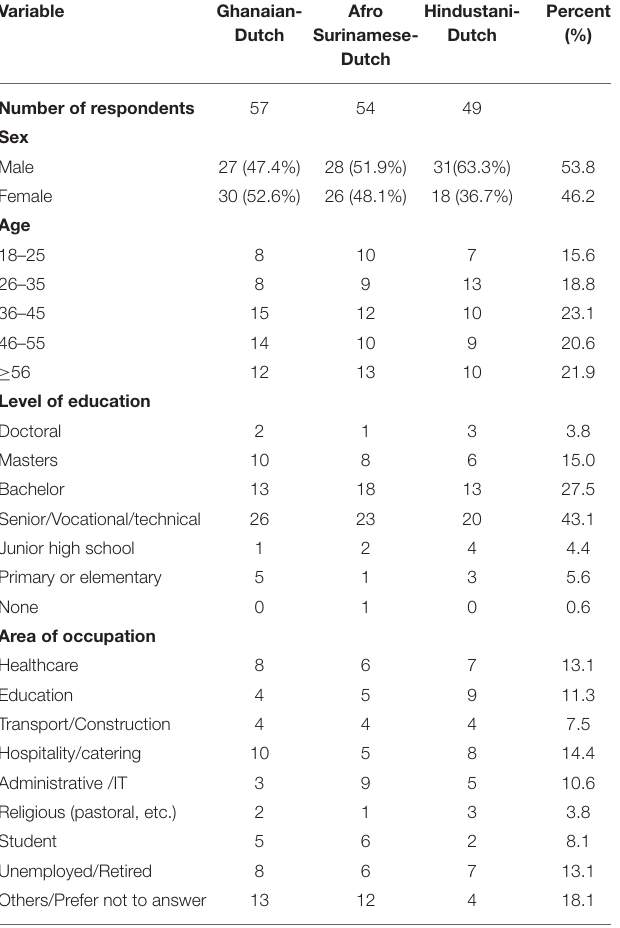
TABLE 1 | Sociodemographic characteristics of respondents from the Ghanaian-Dutch, Afro and Hindustani Surinamese-Dutch communities in Amsterdam. Variable